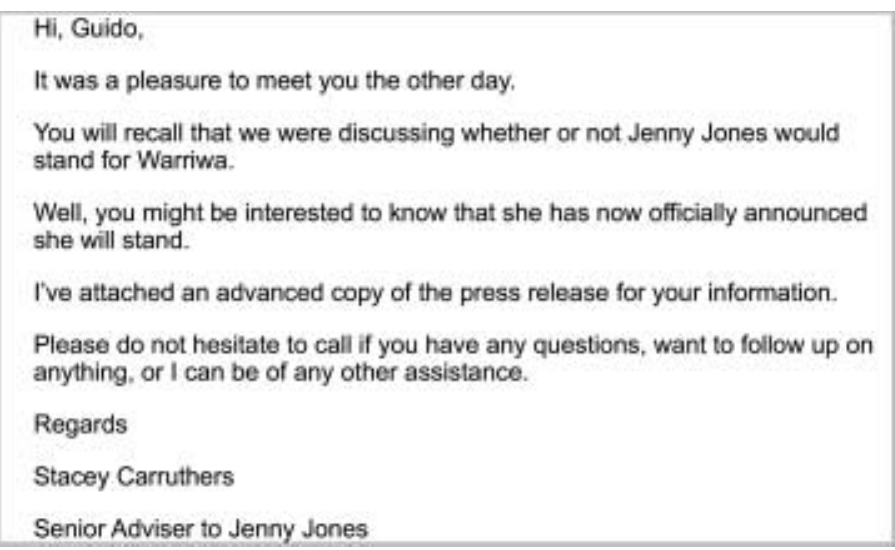
Figure 1. Email extract from adviser student Stacey to journalist